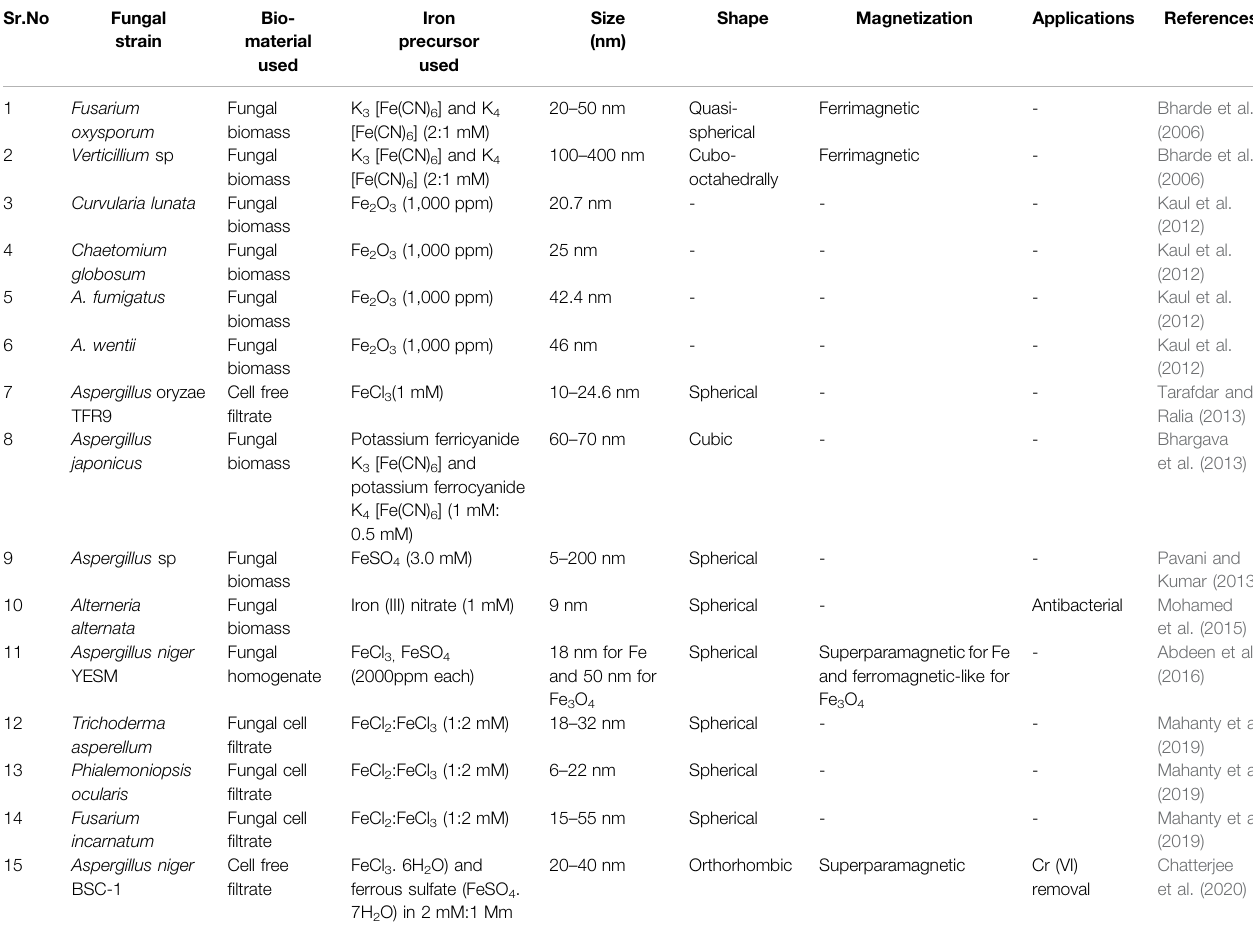
TABLE 2 | Biosynthesis of Iron oxide nanoparticles by using fungi.